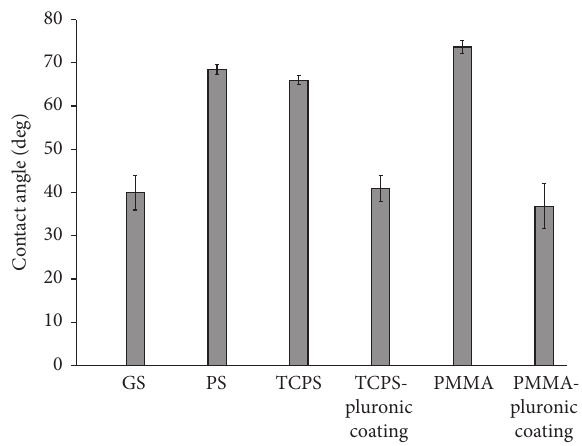
Figure 1: Water contact angle of biomaterial surfaces (GS: glass slide, PS: polystyrene, TCPS: tissue culture polystyrene, and PMMA: poly(methyl methacrylate)) and pluronic coated surfaces.